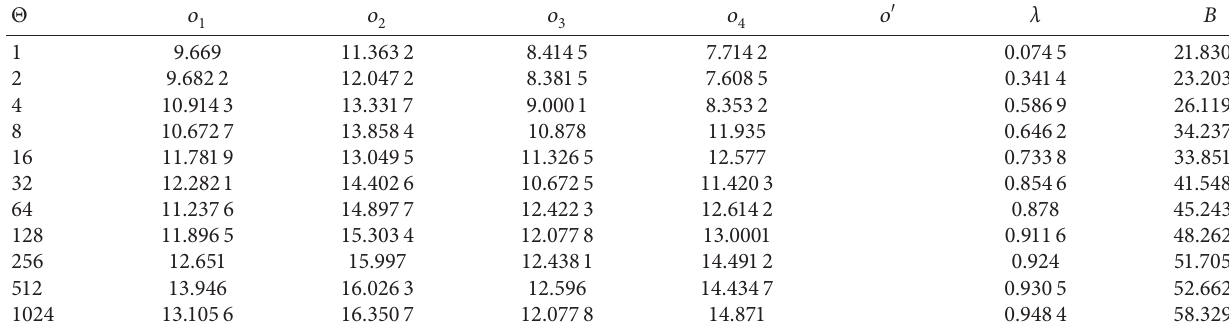
Table 1: Result of model (7).